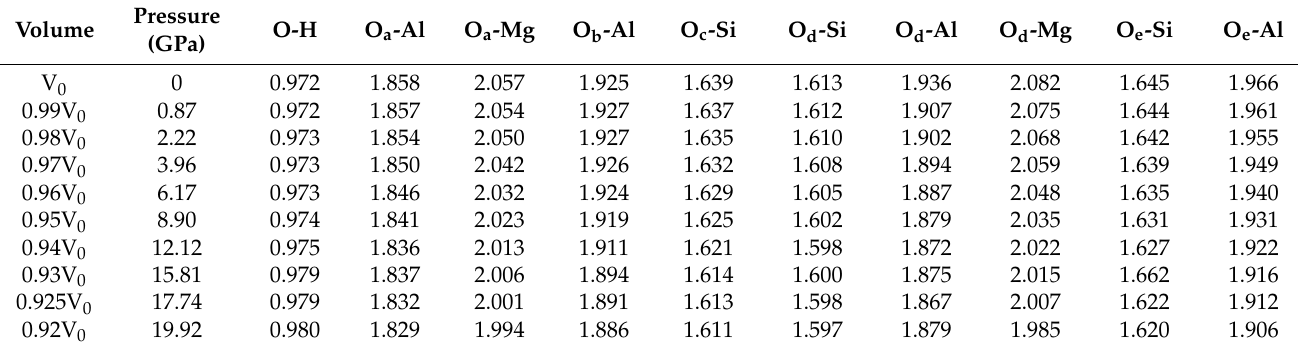
Table 8. The bond lengths (Å) in optimized structure of the Na-MMT under pressure.